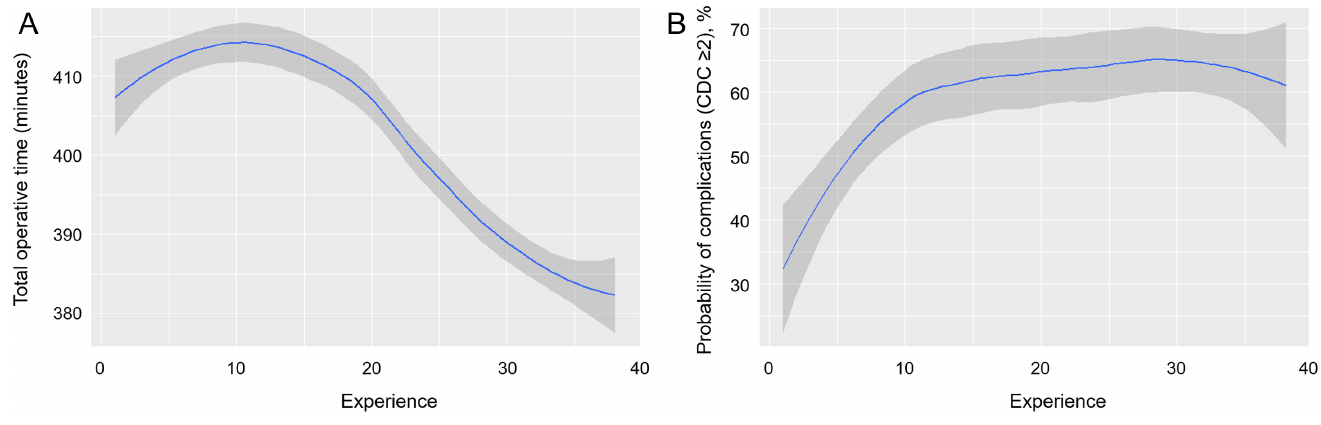
Figure 7. a, b. The surgical learning curve for robot-assisted radical cystectomy and intracorporeal ileal conduit (hybrid approach): effects of increasing surgical experience on total operative time (a) and the rate of postoperative complications (Clavien–Dindo grade ≥ 3)